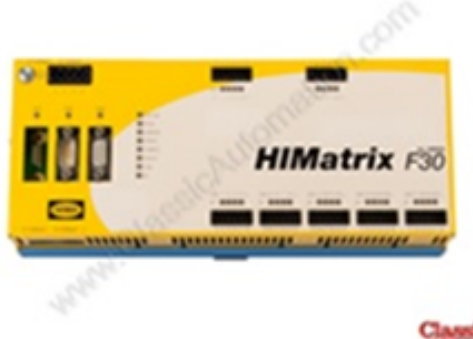
Figure 4. An example HIMatrix controller HW that can be used as object controller.